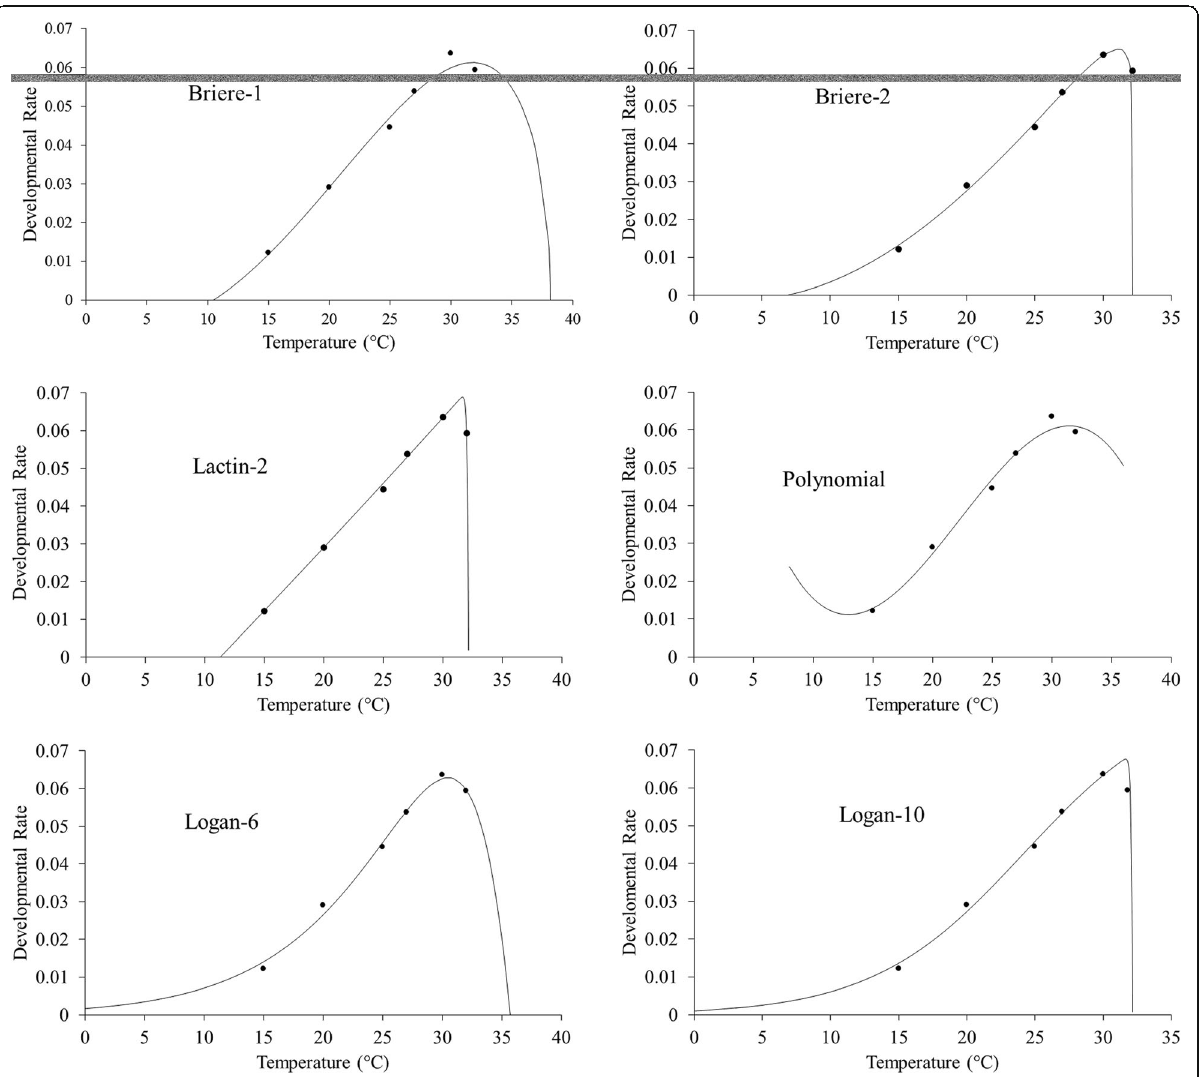
Fig. 1 Fitting six nonlinear models to observed values (black dots) of developmental rate (1/d) of overall immature stages at studied